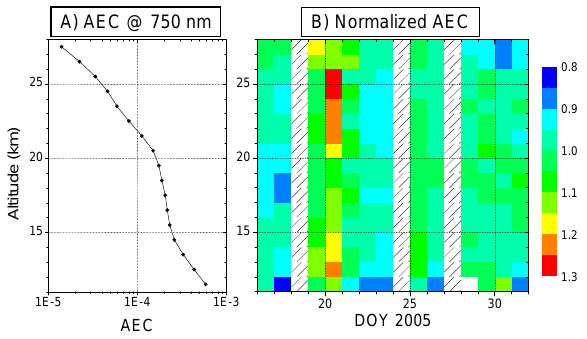
Fig. 7. Averaged OSIRIS aerosol extinction (in km − 1 ) profiles at 750nm measured over the Antarctic region in the second half of January 2005. (A) The average profile for the 16–31 January 2005 period. (B) Normalized (to that shown in A ) daily averaged AEC. Hatched area depicts days with no data